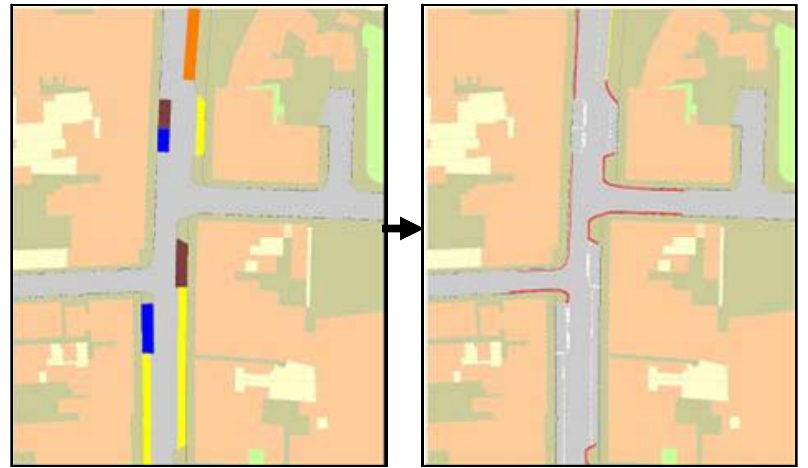
Figure 13. GIS representation of block markings and conversion to road markings Source: Jones and Thoreau (2007), Figure